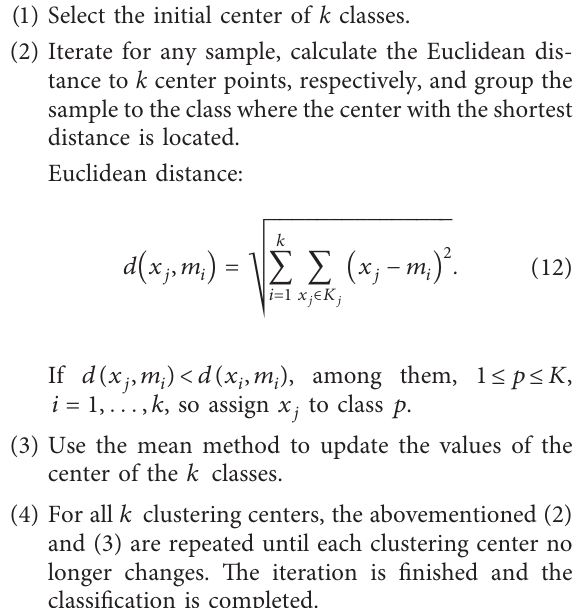
Figure 14: Cluster analysis of